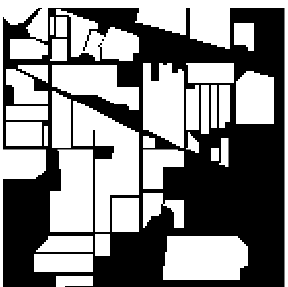
Figure 10. Grayscale image of Indian Pines.